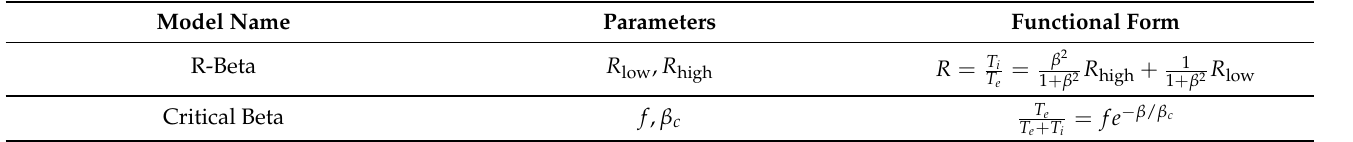
Table A1. JAB Emission Model List. This is a compendium of the phonologically motivated emission models mentioned in this work. The shear stress S = γ 2 | dv z / ds | and dimensional parameters L j and L S are set by the width of jet